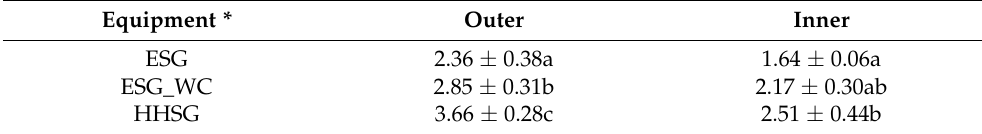
Table 4. Normalised losses to the ground in the outer and inner zones (mean ± SD) in µ L cm − 2 . Equipment *